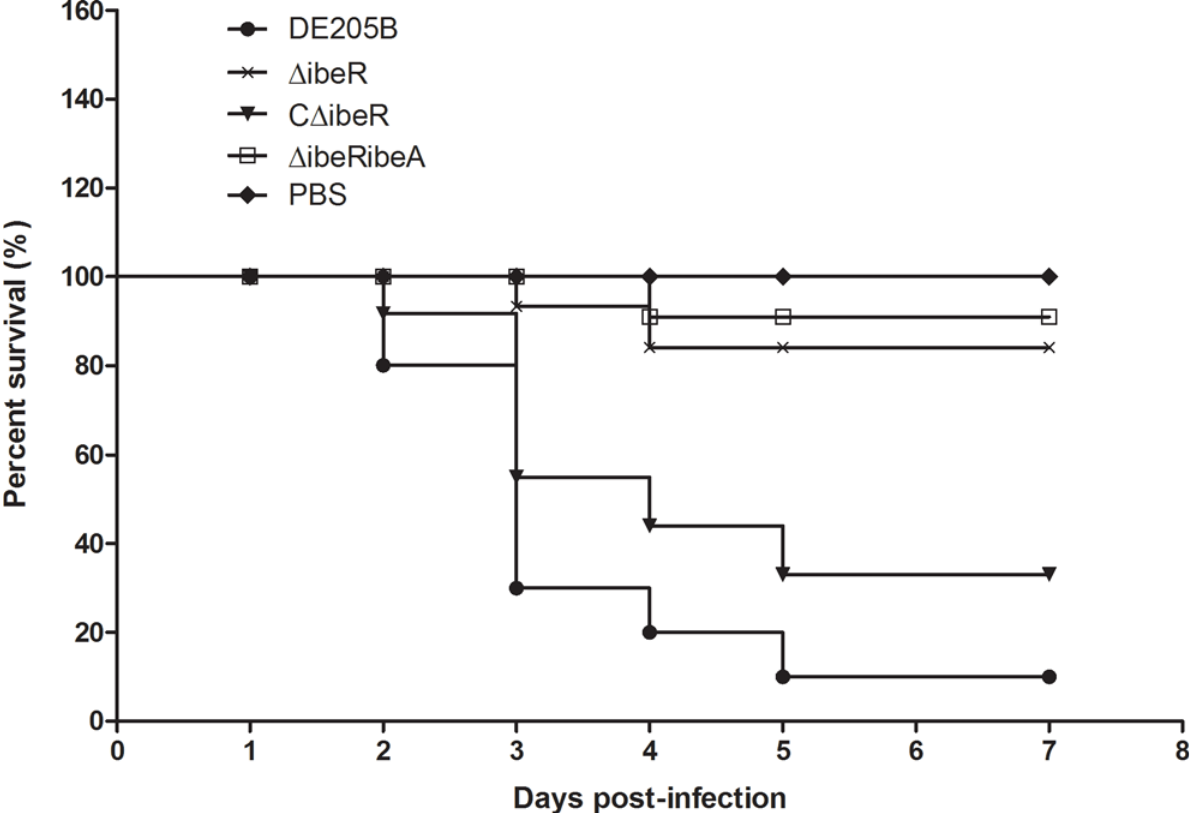
Fig 3. Determination of bacterial virulence. Seven-day-old ducks were inoculated intratracheally with DE205B, Δ ibeR, C Δ ibeR or Δ ibeRibeA at 10 7 colony-forming units (CFUs). Negative controls were injected with PBS. Survival was monitored until 7 days post infection.